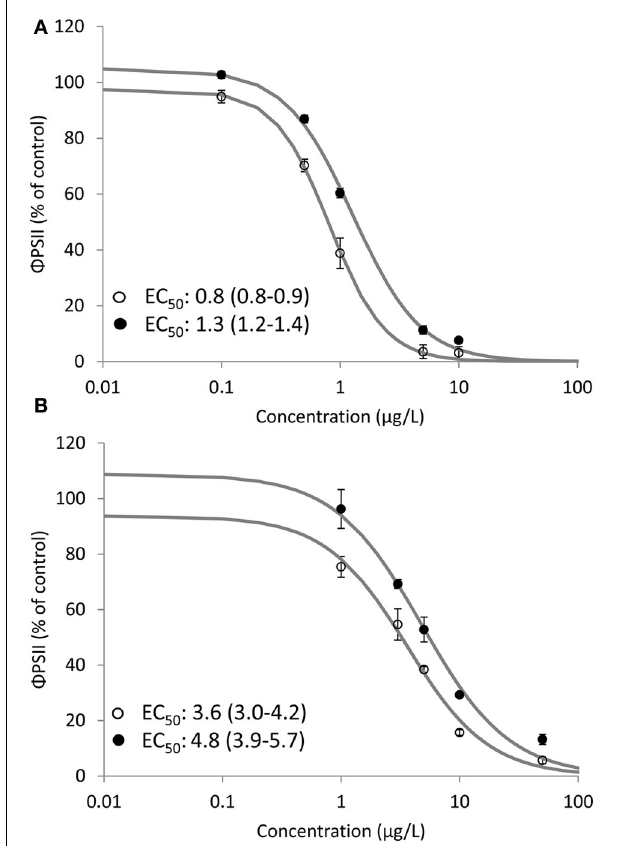
FIGURE 2 | Dose response relationships for Irgarol (A) and diuron (B) on the effective PSII efficiency ( (cid:2) PSII) (% of control) of D. tertiolecta after 4.5h of exposure under two seasonal irradiance regimes. EC 50 values and corresponding 95% confidence intervals ( μ g/L) are presented for all dose response relationships. Open (SPRING) and closed (AUTUMN) circles represent average (cid:2) PSII and the solid line is the log-logistic model. Error bars represent standard deviation. Concentration is expressed as μ g/L. N = 6 for treatments; N = 5 for control.